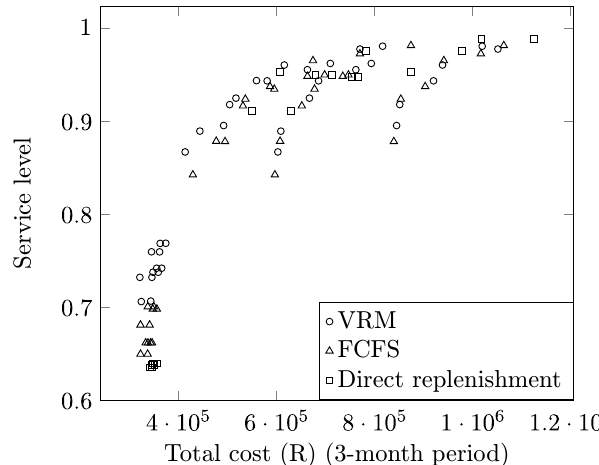
Figure 8: The figure shows the overall effect of the routing method. The direct replenishment method yields very high service level values but at high cost, while the worst service level values also result from this method. The VRM yields good service levels at reasonable cost. The FCFS routing generally gave mediocre